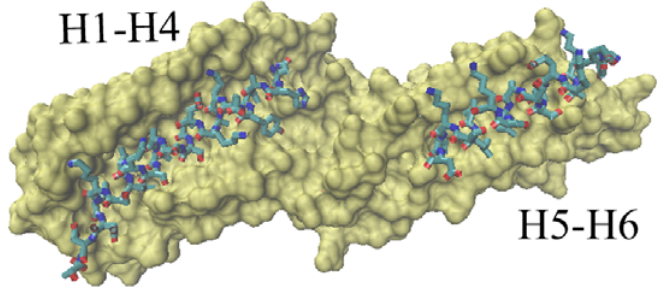
Figure 6. The groove of the vinculin D1 domain bound to other partners. The D1 domain is shown with surf method. The partner is drawn with licorice method. The left part corresponds to the groove formed with H1, H2, H3 and H4. The right groove is formed with H5 and H6. This is a dorsal view of D1